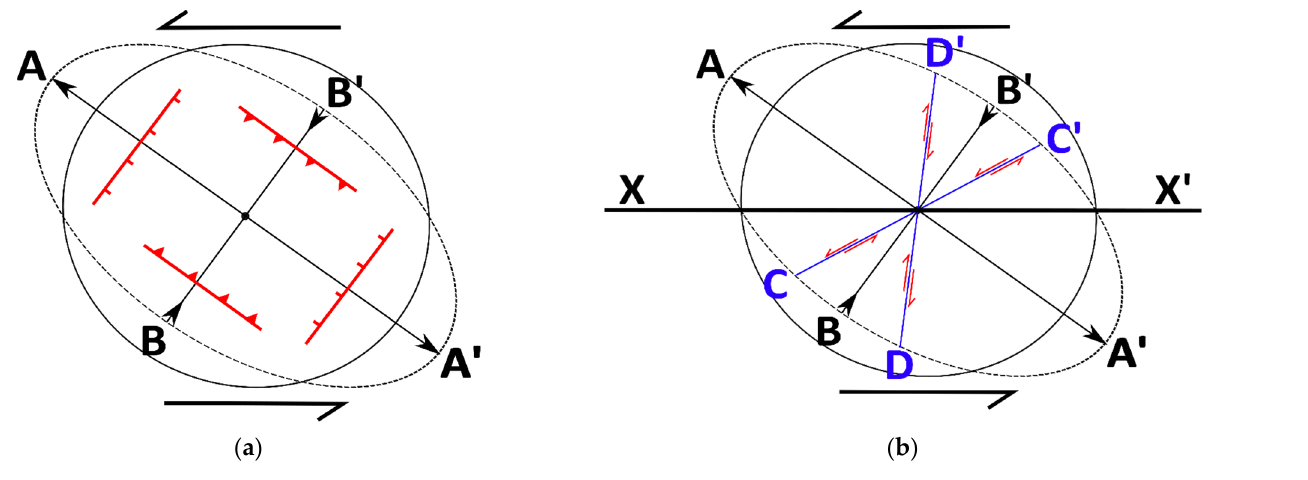
Figure 14. The schematic diagrams to illustrate: ( a ) the sinistral shearing of the Jiujing granite region due to the impacts of NE compression, where the long ellipse axis (AA’) marks the direction of elongation and the short axis (BB’) marks the direction of shortening and ( b ) the shearing properties of high-angle faults (also known as antithetic strike-slip faults, marked by axis DD’) and low-angle faults (also known as synthetic strike-slip faults, marked by axis CC’) under the NE compression. Axis XX’ refers to wrench strike. Modified after Wilcox